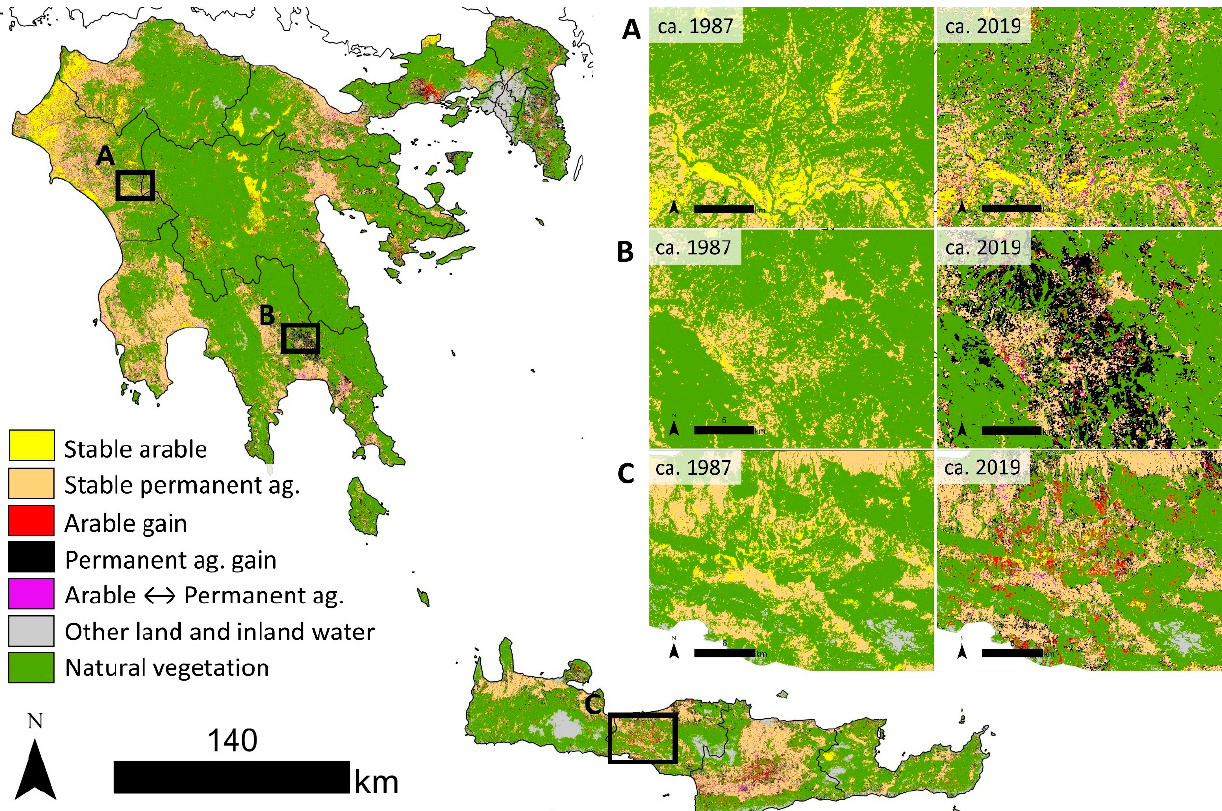
Figure 8. Selected regional hotspots of arable land and permanent agriculture expansion from circa (ca.) 1987 to 2019. Hotspots of permanent agriculture gain were observed in the Ilia region near Kallithea ( A ) and in the Laconia region near Geraki ( B ). Hotspots of arable gain were observed in central Crete, including the Rethymno ( C ) and Heraklion regions. For data visualization purposes, we applied a three-year majority filter to the beginning and ending years to reduce the effects of annual crop rotation.